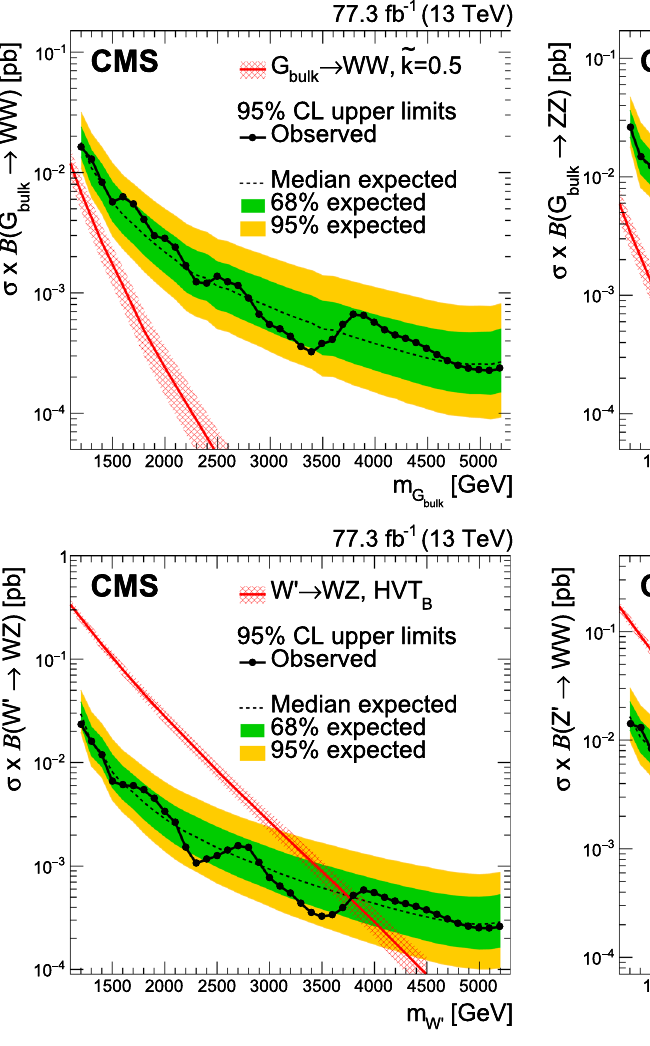
(lower left), and Z (cid:3) → WW (lower right) signals. For each signal sce- nario the theoretical prediction (red line) and its uncertainty associated with the choice of PDF set (red hashed band) is shown. The theory cross sections (red line) are calculated at LO in QCD